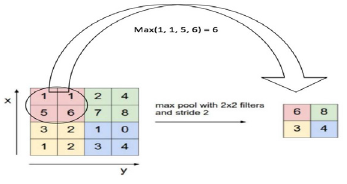
Figure 4. Max pooling